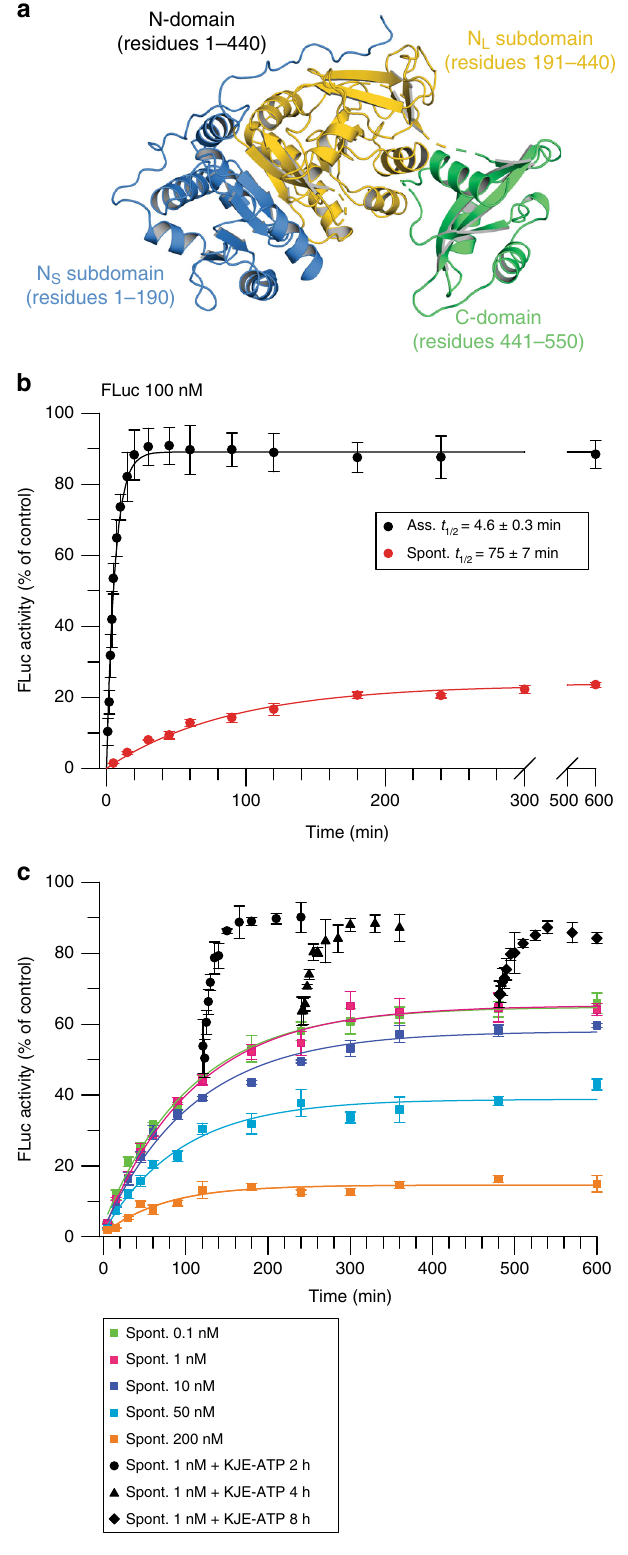
Fig. 2 The KJE chaperone system accelerates FLuc folding. a Structure of FLuc (PDB ID: 1LCI) with domains indicated. b Spontaneous and chaperone- assisted folding of 100 nM FLuc was assayed upon dilution from 5M GuHCl into buffer without or with KJE-ATP, respectively, by monitoring luminescence activity. KJE-mediated folding was performed with 3 µ M DnaK, 1 µ M DnaJ, 1.5 µ M GrpE and 5mM ATP. Error bars represent s.d. ( n = 10). c Concentration dependence of FLuc refolding. FLuc was diluted from denaturant to different fi nal concentrations (0.1 – 200 nM) and refolding assayed as in ( b ). Rescue of spontaneous folding reactions was assayed by adding KJE-ATP (0.3 µ M DnaK, 0.1 µ M DnaJ, 0.5 µ M GrpE and 5mM ATP) after 2, 4 or 8 h. Error bars represent s.d. ( n = 3). Ass., KJE-ATP-assisted; Spont., spontaneous folding. Source data are provided as a Source Data fi le.